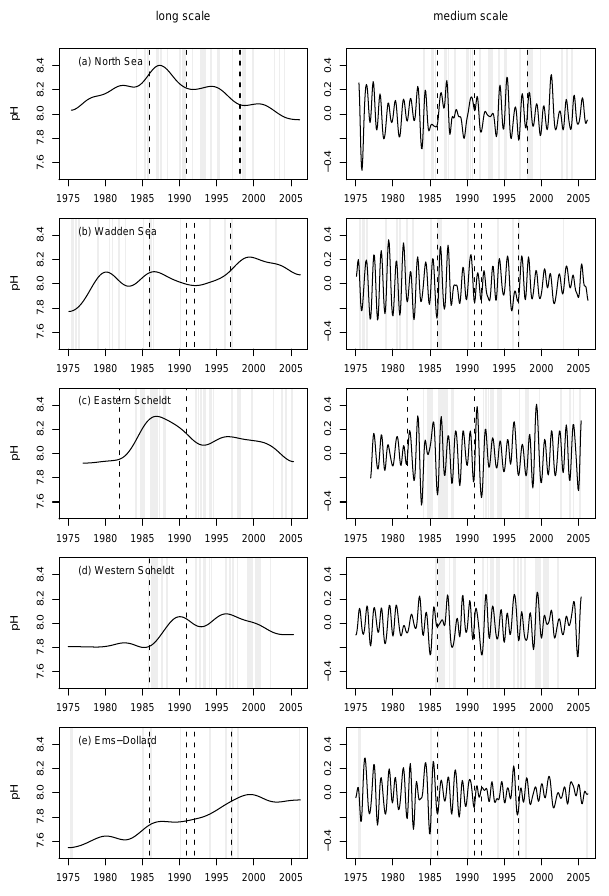
Fig. 4. Medium- (MODWT D3+D4+D5, right) and long-term (MODWT D6+D7+D8+S8, left) signals from the selected sta- tions.